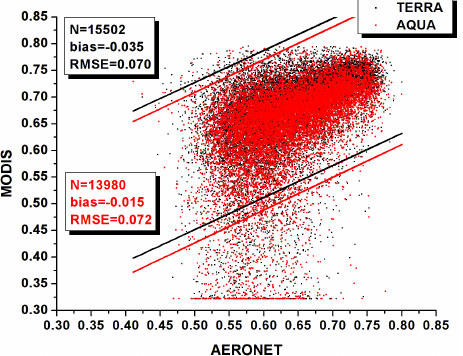
Figure 9. Scatterplot comparison between g aer values at 860nm from MODIS Terra (black color) and Aqua (red color) and corre- sponding values from AERONET stations at 870nm (blue squares, Fig. 1). The 95% prediction bands as well as the mean bias (AERONET minus MODIS) and root mean squared error are given.